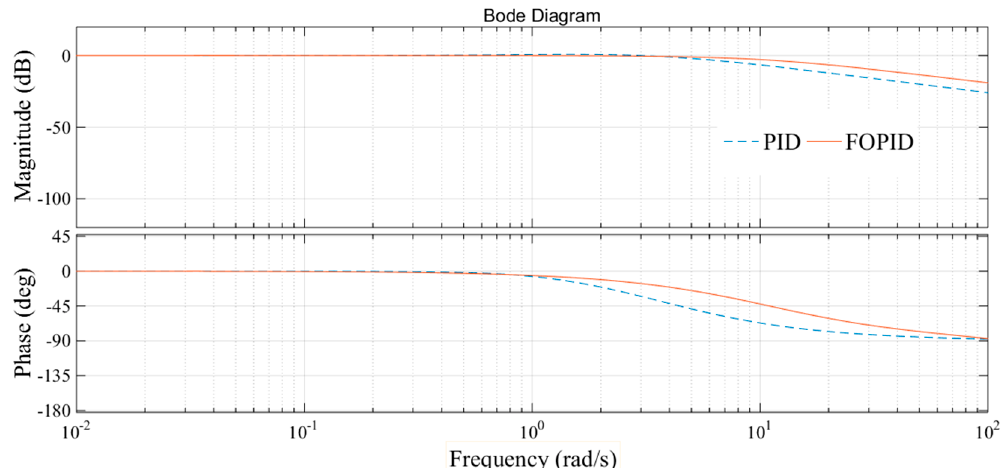
Figure 12. Bode plots of close loop. Figure 12. Sine input signal tracking response.